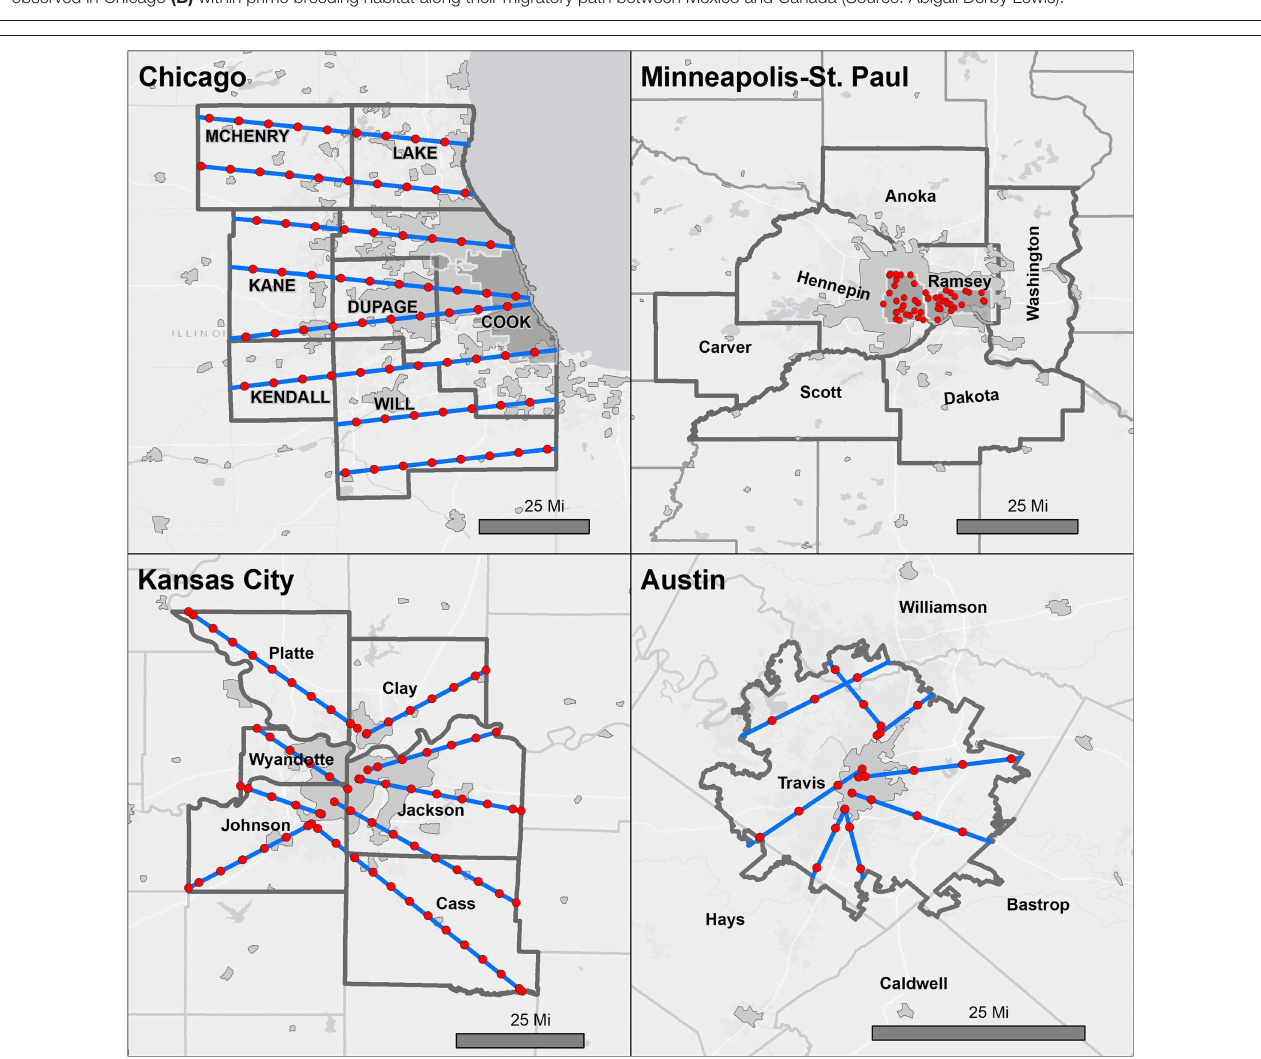
Frontiers in Ecology and Evolution | www.frontiersin.org